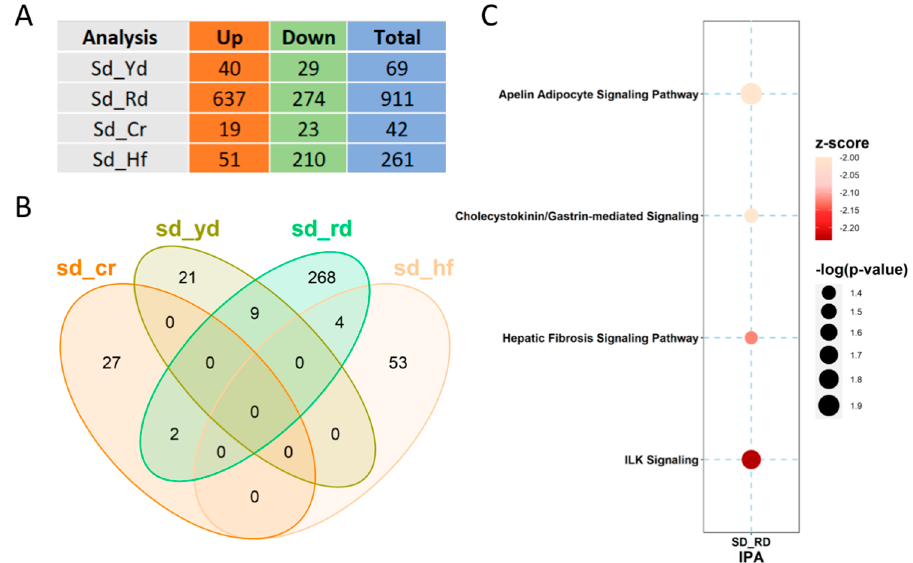
Figure 4. Comparisons of the H3K4me3 signals genome-wide and on promoters: ( A ) Comparison of the number of different peaks identified genome-wide by diet, as indicated. ( B ) Venn diagram of the promoter regions differentially marked with H3K4me3 by the different diets with respect to the SD. ( C ) IPA-identified pathways for the genes whose promoters are differentially marked by the RD.